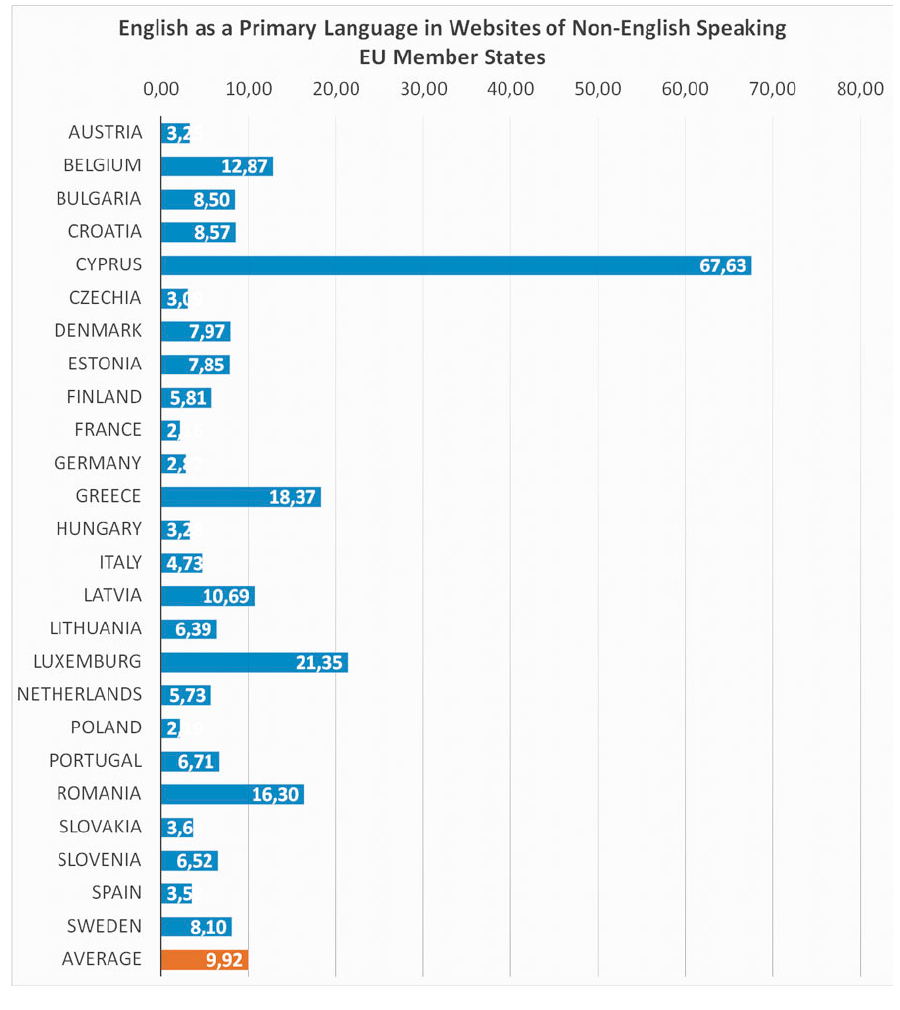
Figure 10. English as a Primary Language in Websites of Non-English Speaking EU Member States.